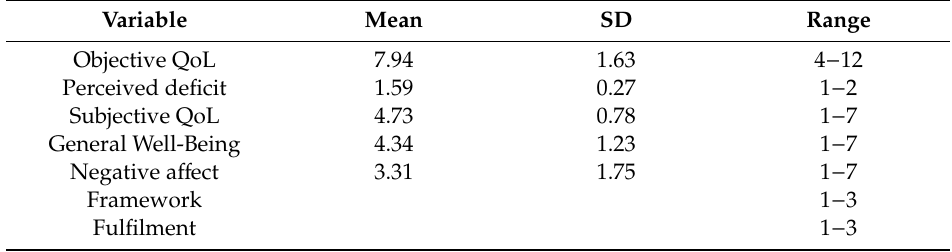
Table 2. Research variables used to operationalise Cummins’